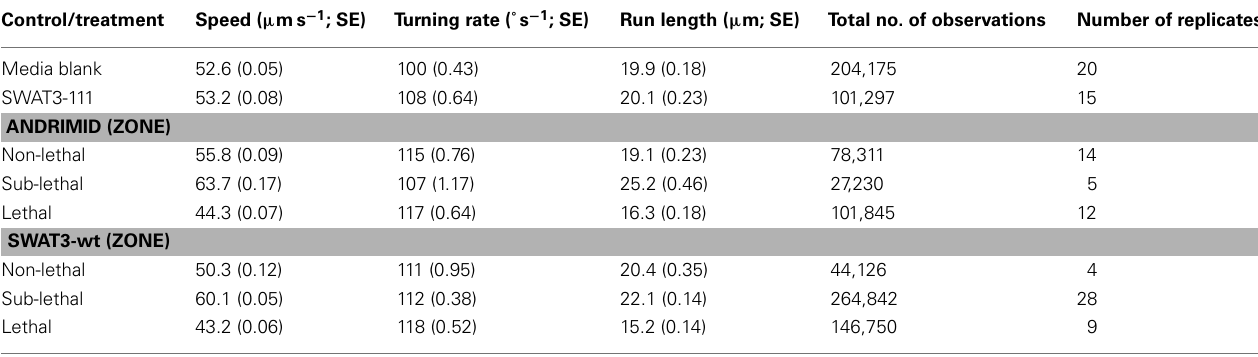
Table 1 | Mean swimming behaviors for each control and for each defined zone for each